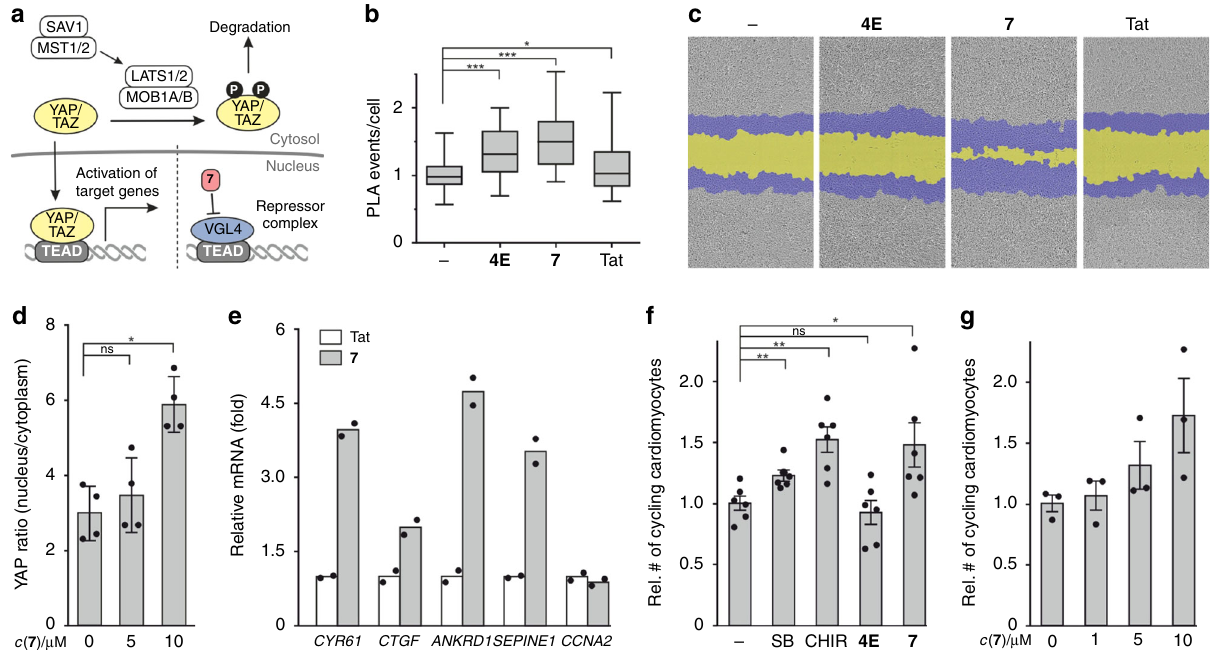
Fig. 4 Cellular activity of 7 in RKO cells and in primary juvenile cardiomyocytes was investigated. a Schematic overview of the Hippo signalling pathway. Presence of 7 inhibits formation of repressor complex, thereby supporting TEAD-dependent target gene expression. b Proximity ligation assay (PLA) to probe the YAP – TEAD interaction in RKO cells. Peptides were incubated for 24 h ( c = 30 µ M). Untreated cells were used as control. PLA was performed using YAP and TEAD antibodies (centre: mean, whiskers: minimum to maximum, box: lower to upper quartile; for details, see Methods section, n = 3 biologically independent experiments with two n = 2 technically independent replicates each). c Representative images of wound healing assay of RKO cells treated with different peptides ( c = 30 µ M, cell front is represented before (blue) and after 48 h treatment (yellow)). The experiment was performed in n = 3 biologically independent replicates each with n = 3 technically independent replicates. d Effects of 7 on YAP distribution (nucleus/cytosol). Juvenile rat heart cells were treated with peptide 7 (10 µ M) or DMSO vehicle for 4 h, fi xed and stained (DAPI, α Actinin, YAP). Nuclear and cytosolic YAP levels in cardiomyocytes were quanti fi ed by image analysis (primary juvenile (P5 – P6) rat cardiomyocytes, n = 3 – 4 biologically independent replicates, error bars = SEM). e qPCR analysis of the TEAD target genes. Bars represent the mRNA fold-changes of CYR61 , CTGF , SEPINE1 , ANKRD1 , and CCNA2 genes after 18 h treatment with 7 (red) relative to Tat (cardiomyocytes generated from human ES cell line (H7), n = 2 biological replicates with n = 3 technical replicates each). f High-content imaging-based analysis of cell cycle activity in primary juvenile (P5 – P6) rat cardiomyocytes after 4 days. Untreated ( – , DMSO) or treated ( c = 10 µ M) with p38MAPK inhibitor SB203580 (SB), GSK3 β inhibitor CHIR99021 (CHIR), 4E or 7 (plotted relative to DMSO-treated cells, 6 biological replicates, error bars = SEM). g Dose-dependent cell cycle stimulation after 4-day treatment with 7 (primary juvenile (P5 – P6) rat cardiomyocytes, plotted relative to DMSO-treated cells, n = 3 biological replicates, error bars = SEM). For all the experiments, statistical signi fi cances were determined by Student ’ s paired t test; p < 0.05 was considered statistically signi fi cant ( p < 0.05 = *; p < 0,01 = **; p < 0.001 = ***, p < 0.0001 = ****) and source data are provided as a Source Data fi